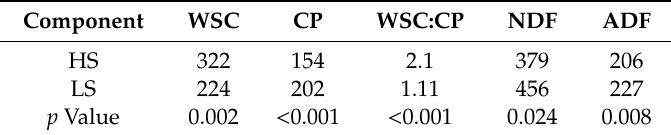
Table 1. Nutritional composition (in g kg − 1 dry matter (DM), except for the WSC-to-CP ratio) of perennial ryegrass swards sown with either a high-sugar (HS) cultivar (Expo) grazed at three leaves per tiller and fertilised with an annual N fertilisation rate equivalent to 83.3 kg N / ha or a standard cultivar (Extreme) grazed at two leaves per tiller and fertilised with an annual N fertilisation rate equivalent to 250 kg N / ha (LS) in autumn. Component WSC CP WSC:CP NDF ADF HS 322